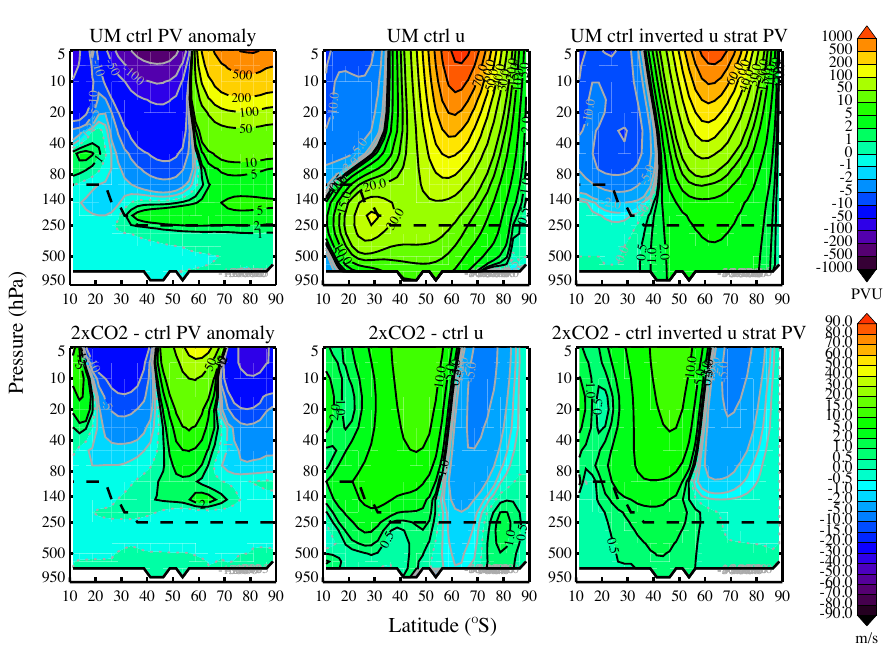
Fig. 7. Same as Figure 5 but for August in the SH (minus the PV anomaly values are shown). Fig. 7. Same as Fig. 5 but for August in the SH (minus the PV anomaly values are shown).